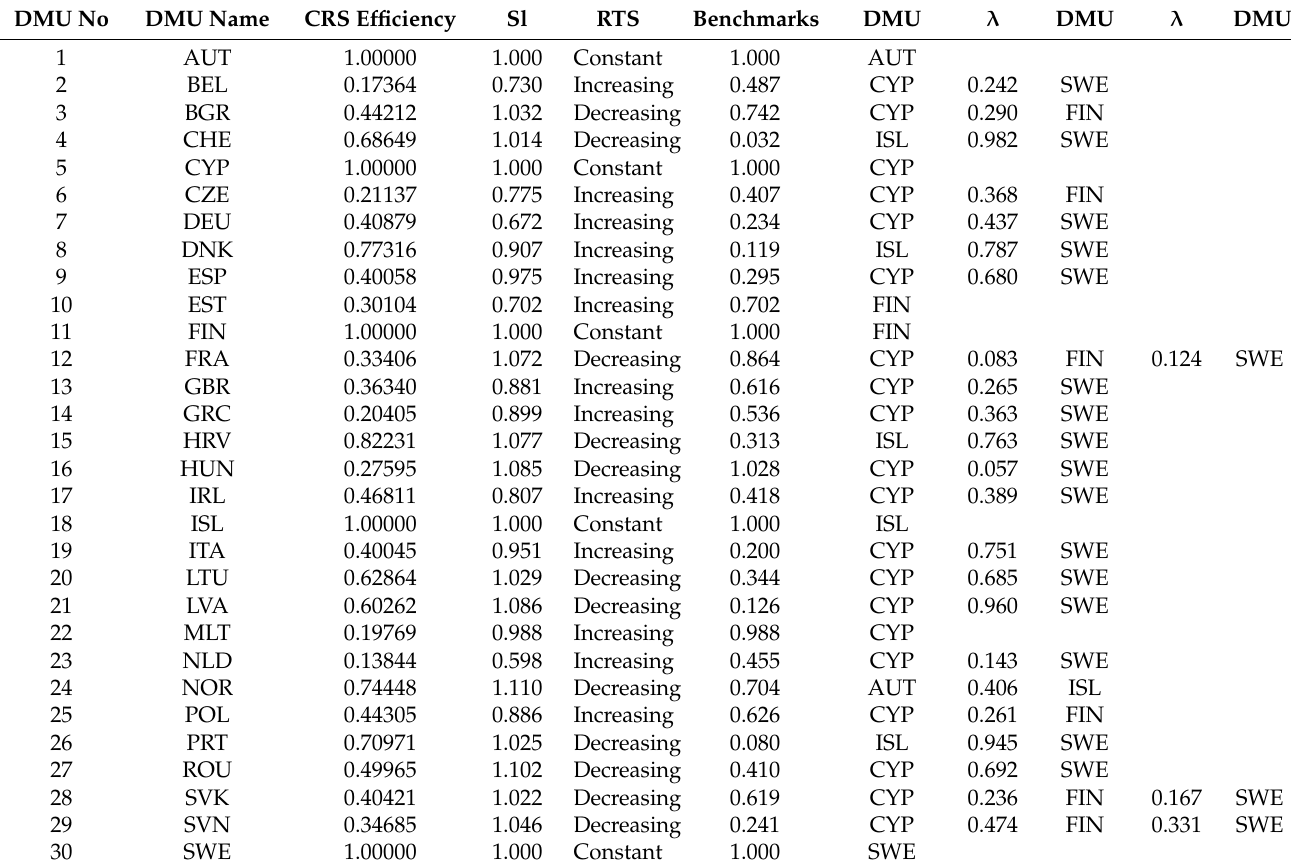
Table A1. Input-Oriented CRS Efficiency of EPS in 2014. Source: Authors’ calculations in DEAFrontier.